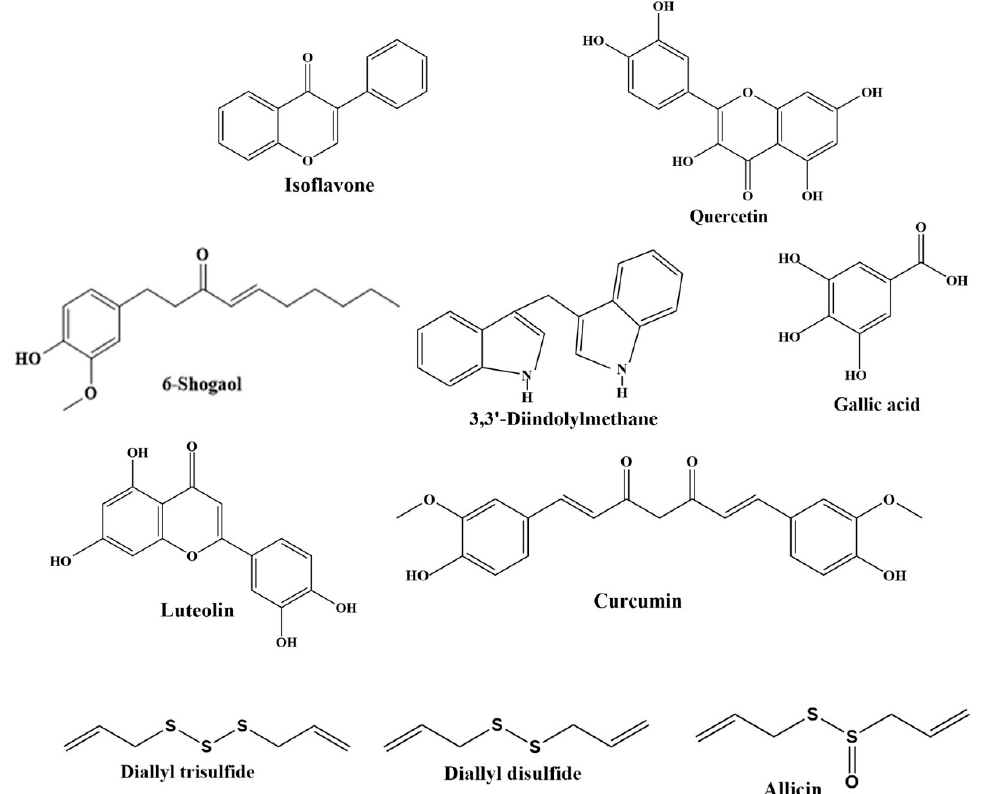
Figure 1. Chemical structures of several phytochemicals against gastric cancer.